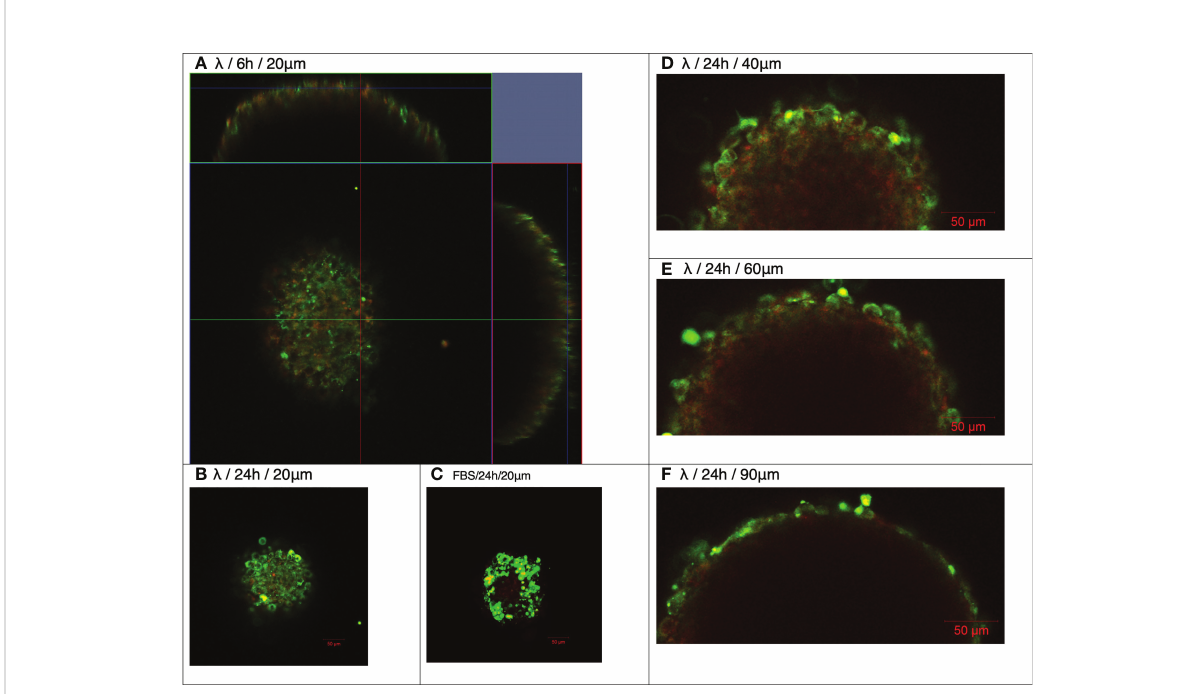
FIGURE 3 Association and penetration of l phages with NIH3T3 fi broblast spheroids. NIH3T3 spheroids (d7, 250 – 350 m m in diameter) were exposed to either WT l phages tagged with Alexa Fluor488 (A,B, D – F) or FBS tagged with Alexa Fluor488 (C) for the times shown. Spheroids were washed to discard unbound phages or FBS, and counterstained with CellTracker ™ Red prior to imaging by confocal microscopy at the Z planes indicated ( m